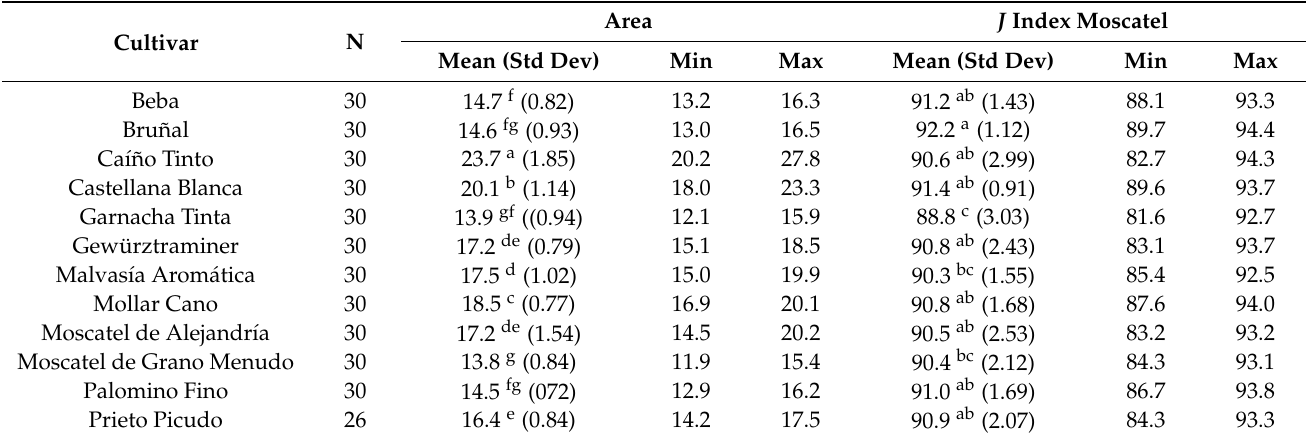
Table 7. Values of area and J index in the cultivars of the Moscatel group. Superscript letters indicate the results of Scheff é test: the mean values marked with the same letter in the superindex of each column do not differ significantly at p < 0.05. N is the number of seeds analyzed.